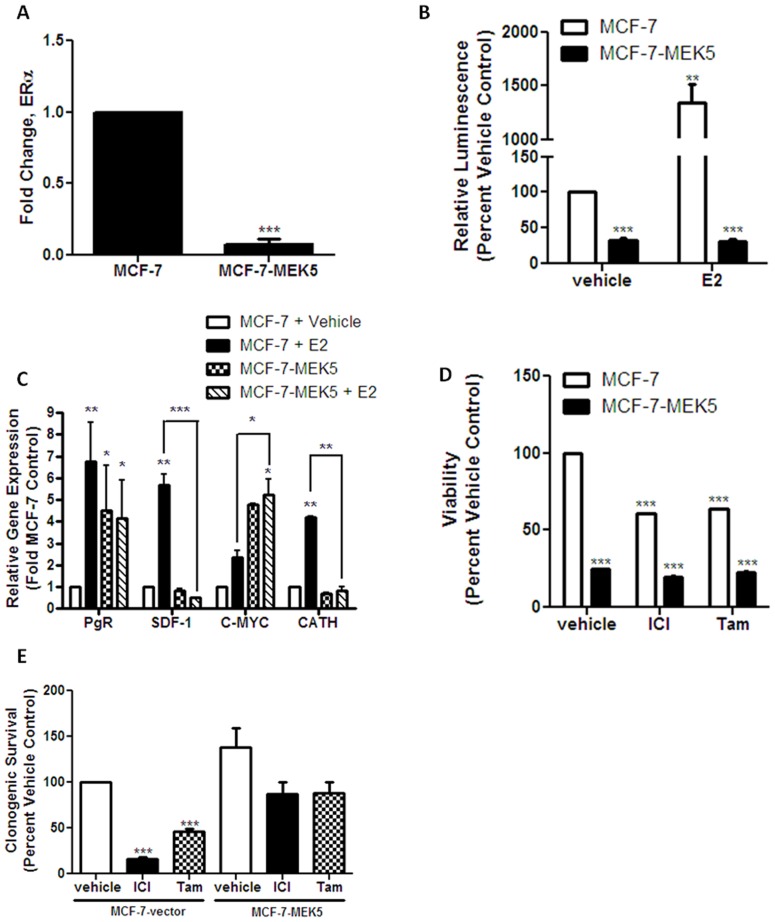
MEK5 expression decreases ER signaling and confers endocrine resistance.(A) MCF-7-vector and MCF-7-MEK5 cells were harvested for total RNA isolation and expression of ER-α mRNA determined using qRT-PCR. Data is represented as mean fold stimulated gene expression normalized to β-actin and vector cells designated as 1. Error bars represent SEM, n = 3. (B) ERE luciferase for MCF-7-vector and –MEK5 cells transiently transfected with pGL2-ERE2X-TK-luciferase plasmid and treated with E2 or vehicle for. Results represent normalized luminescence. Normalization was to vector treated with vehicle and designated as 100 (C) qRT-PCR for MCF-7-vector and –Mek5 cells was performed for E2 responsive genes PgR, SDF-1, c-MYC and Cathepsin-D following E2 treatment. Data is represented as mean fold stimulated gene expression normalized to vehicle treated MCF-7-vcetor cells designnated as 1. Error bars represent SEM, n = 3 independent experiments. (D) MTT ana;ysis of MCF-7-vector and –Mek5 cells following treatment with indicated concentrations of vehicle, ICI or Tam for 24 hours. Data are presented as mean percentage of vehicle treated samples with vehicle normalized to 100. Error bars represent S.E.M., n = 4 independent experiment. (E) Colony assay for MCF-7-vector and –Mek5 cells following treatment with DMSO (vehicle), ICI or Tam. Cells were allowed to grow for 10 days. Colonies of >50 were counted as positive. Results were normalized to percent clonogenic survival of vehicle control cells. Data represented as mean ± S.E.M., n = 4 independent experiments. *, P<0.05; **, P<0.01; ***, P<0.001.